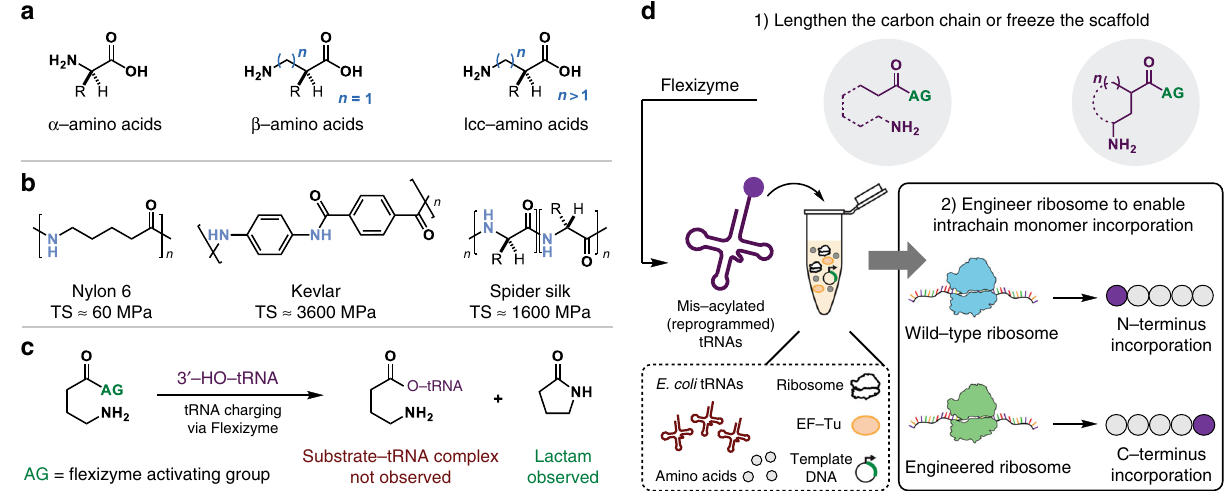
Fig. 1 Expanding the chemical substrate scope of the translation apparatus to include long chain carbon and cyclic amino acids. a Substrates for translation compatible with the fl exizyme (Fx) and cell-free protein synthesis (CFPS) platforms. Long chain carbon (lcc) amino acid incorporation into peptides has proved challenging. b Examples of prominent polyamide polymers that possess signi fi cantly different properties, such as tensile strength (TS), based on backbone length, monomer functionality, and/or monomer sequence. c tRNA charging of lcc amino acids by the Fx system has remained challenging due to the resulting intramolecular lactam formation. d Strategy for incorporation of long chain carbon amino acids via Fx and in vitro